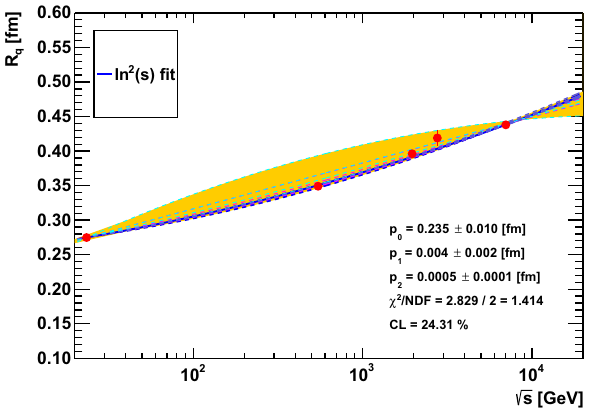
Fig. 19 The scaled energy dependence of the ReBB model parameters by the parameter values at 7 TeV. The original logarithmic excitation functions of the parameters are presented in Ref. [42]. The lower limit of the H ( x ) scaling from the linear logarithmic dependence is obtained √ s = 2436 GeV at